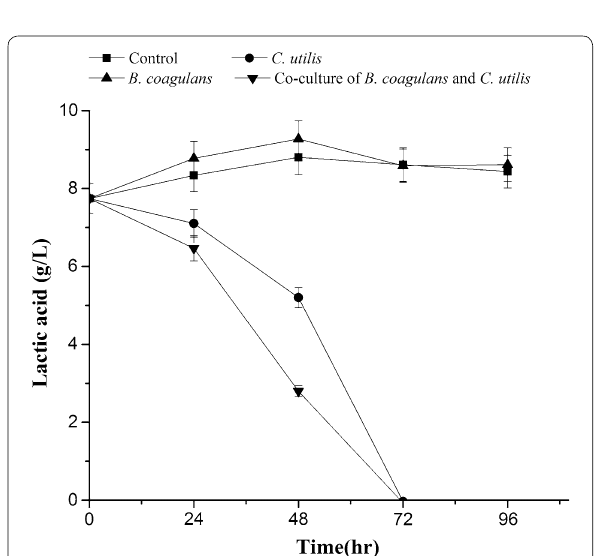
Fig. 4 Removal of lactic acid from LFW by B. coagulans and C. utilis